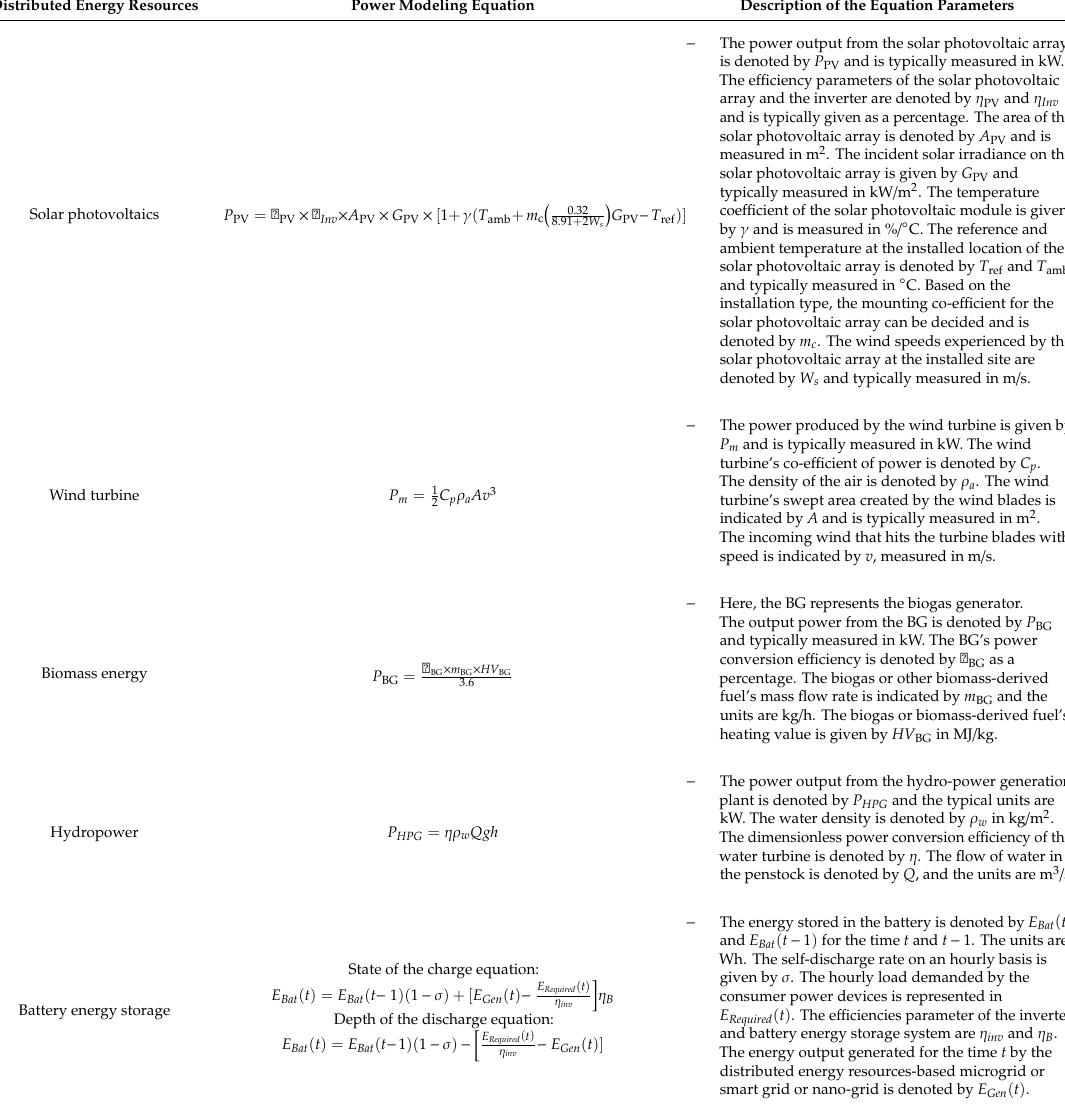
Table 1. Power modeling equations of different distributed energy resource technologies [13,55,56].